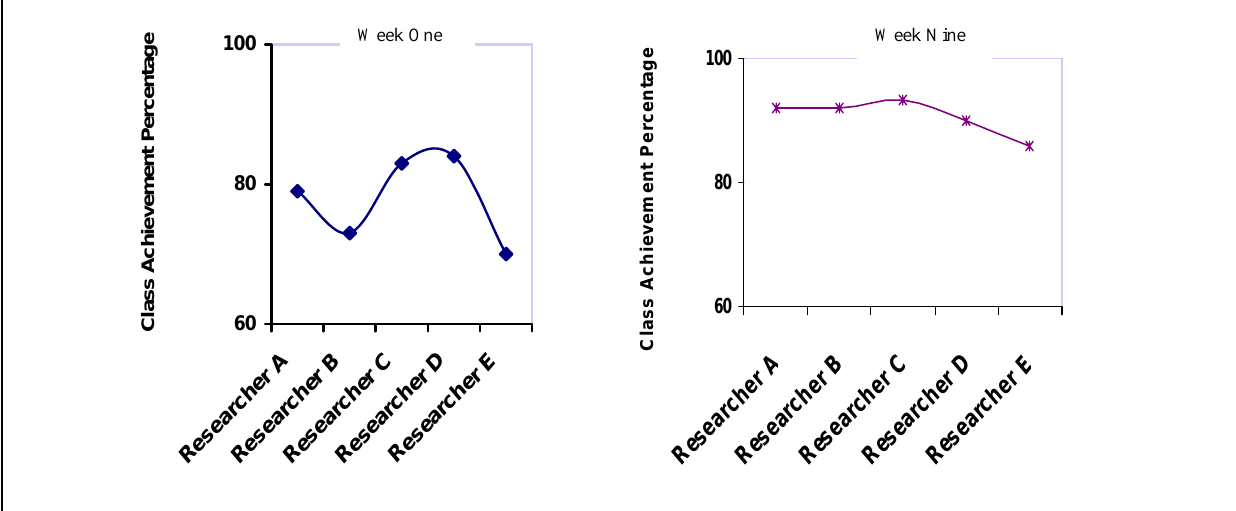
Figure 18. Week One and Week Nine Class Achievement Record side by side